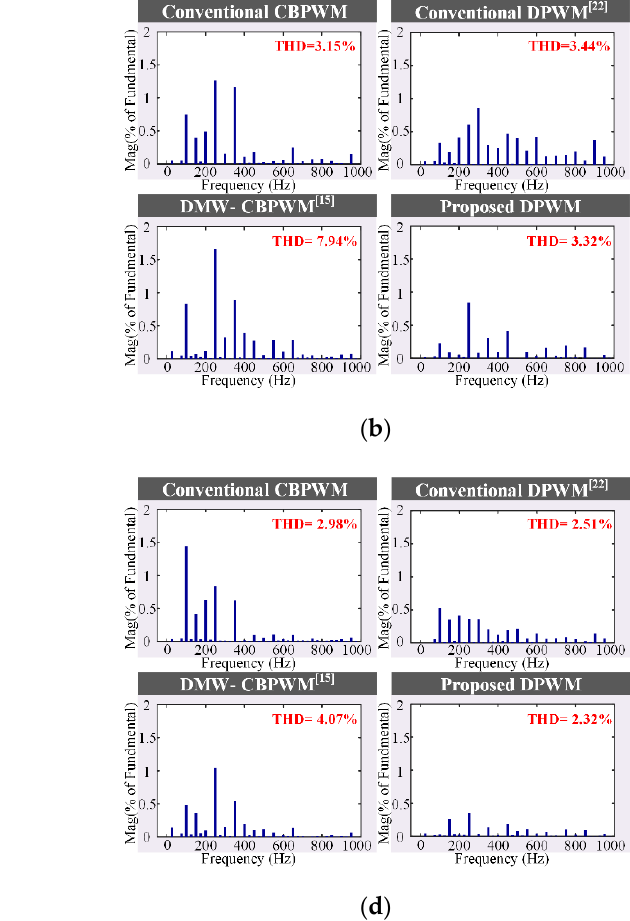
Figure 13. Switching sequences and the corresponding CMV in a unit carrier period for the four tested strategies.